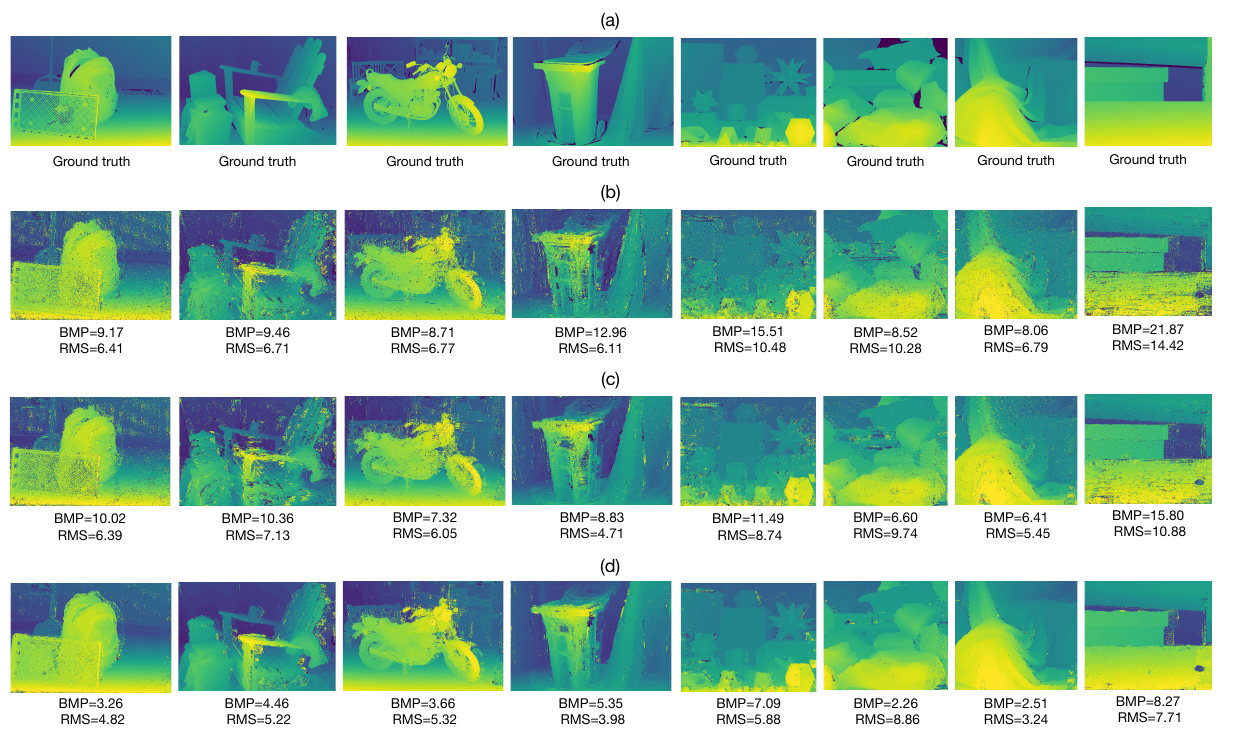
Figure 5. Results of disparity post-processing using the suggested method. ( a ) Ground truth disparity maps. Post-processed disparity maps with the suggested method, obtained with: ( b ) IWCT, ( c ) AD-C and ( d ) Proposed